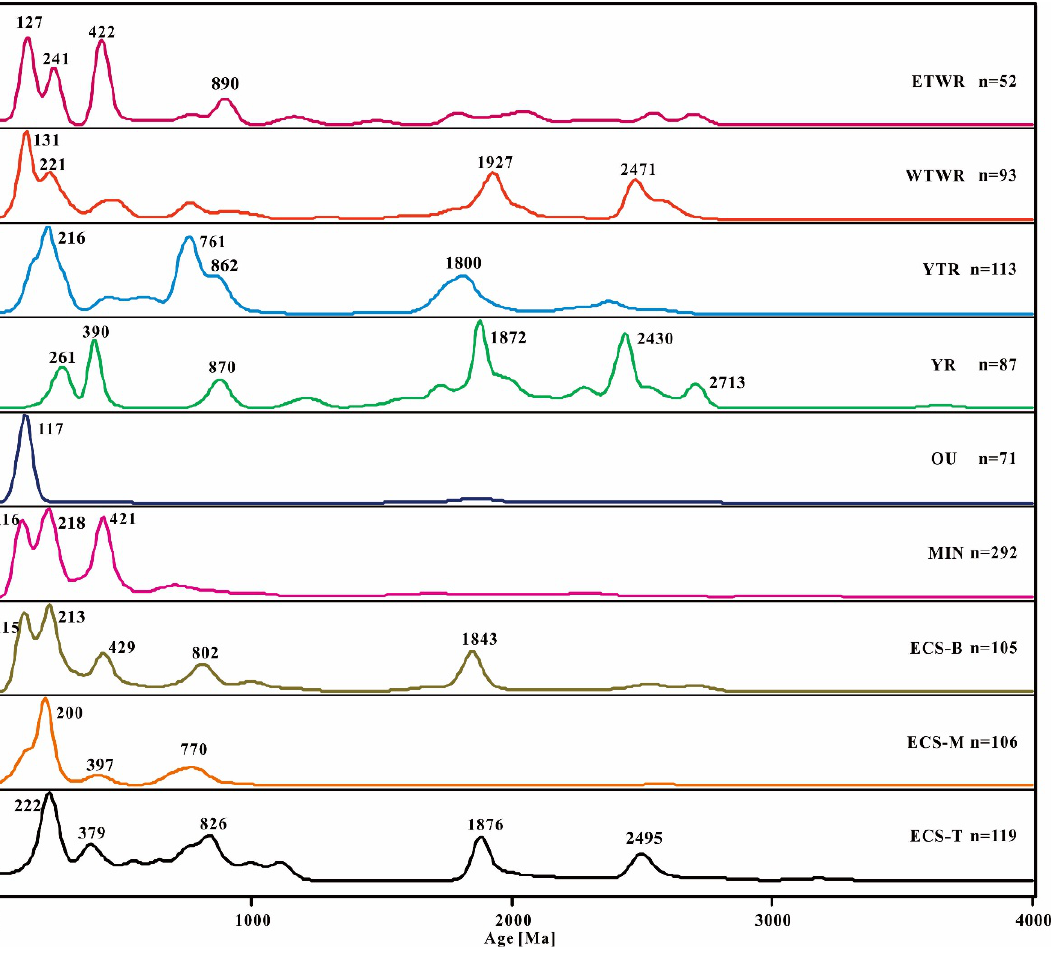
Figure 5. Kernel density estimation (KDE) plots for detrital zircon U-Pb ages of Lanyang river mouth [33], Zhuoshui river mouth [33], the Yangtze River mouth [36], Yellow River mouth [50], Oujiang mouth [34], Minjiang mouth [37], and the East China Sea shelf [6]. Please refer to Table S1 for detailed data. The values of major age peaks are marked in this figure.